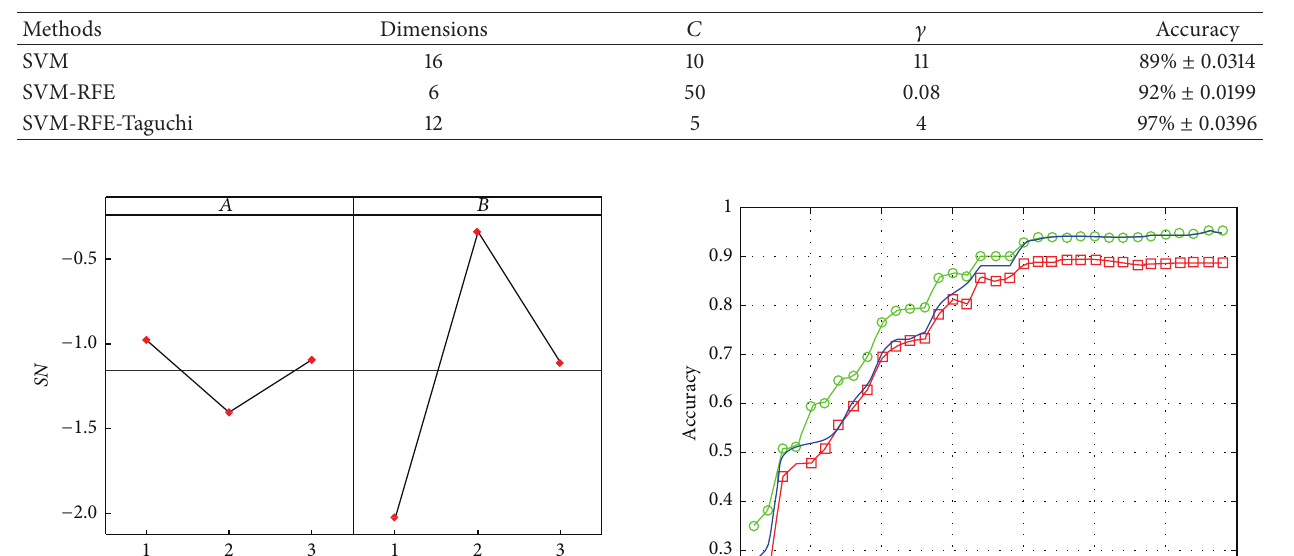
Table 10: Classification performance comparison of Zoo database.